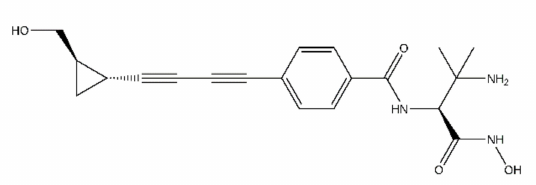
Figure 1. Chemical structural formula of